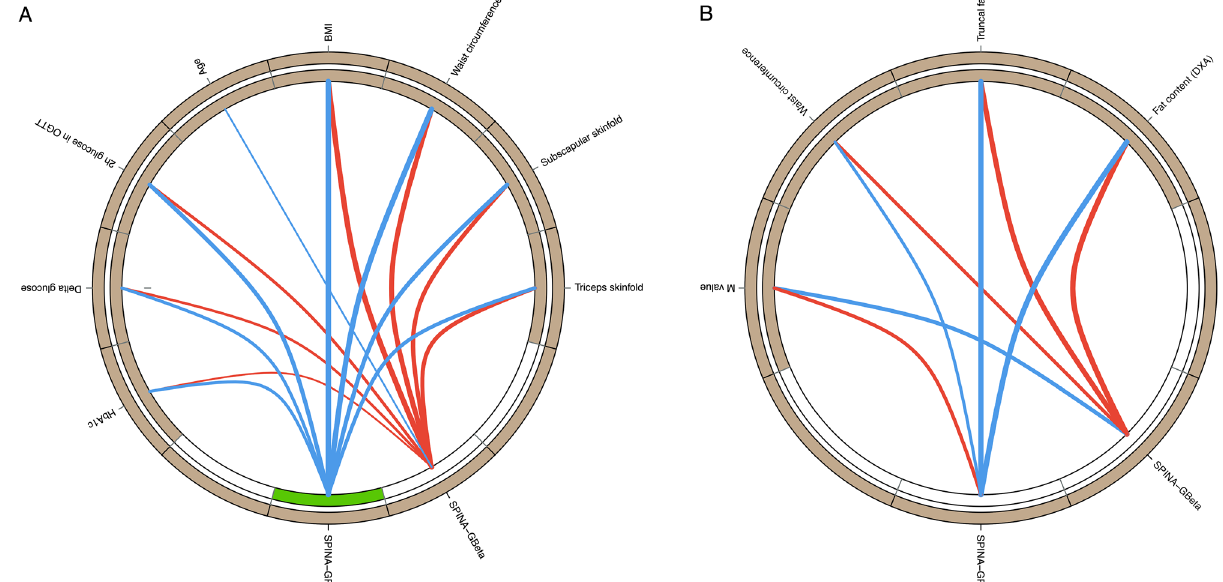
Figure 2. Circular Maps of the correlation networks of novel biomarkers for insulin-glucose homeostasis with anthropometric and experimental data in the NHANES cohort ( A ) and the clamp study ( B ). Shown are significant correlations (p < 0.05) only, and line thickness indicates the strength of negative (blue) or positive (red) correlation. A green segment in the inner ring indicates a reduction of the corresponding biomarker in subjects with